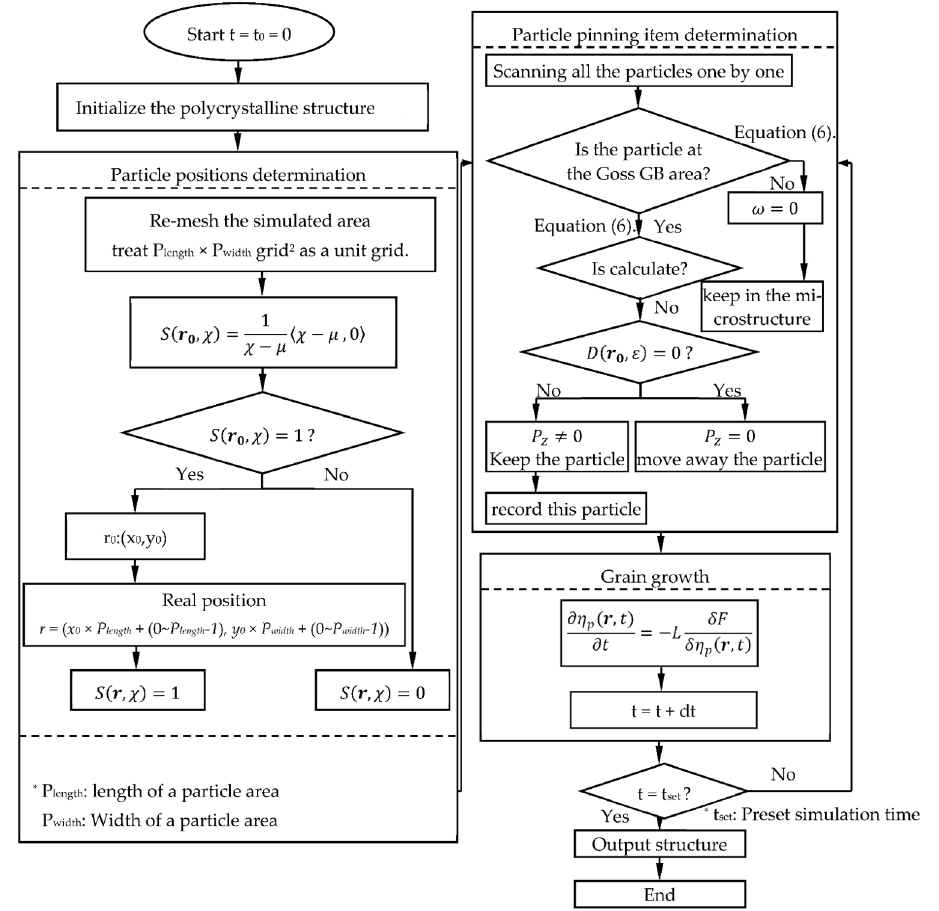
Figure 3. Flow diagrams of phase-field model in this work. The polycrystalline structure initialization refers to [34].